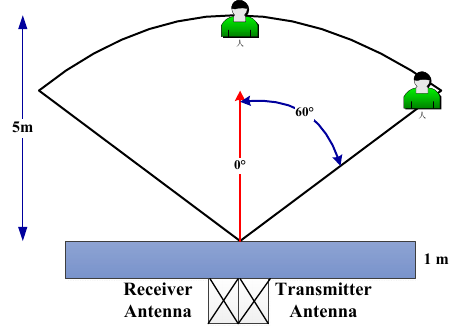
Figure 3. The conducted azimuth experiments.